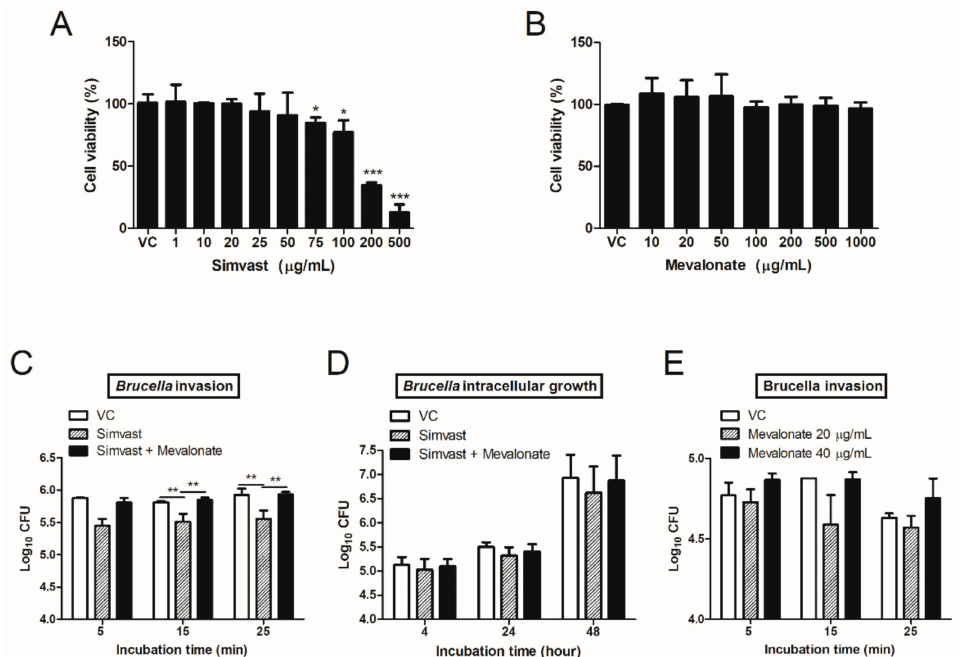
Figure 1. Simvastatin and mevalonic acid treatments affect RAW 264.7 cell viability and B. abortus invasion into RAW 264.7 cells. The MTT assay was used to analyze the cytotoxic effects of simvastatin ( A ) and mevalonic acid ( B ) on RAW 264.7 macrophage cells. The B. abortus invasion into